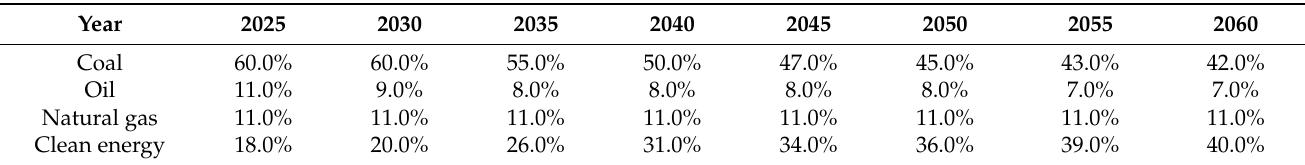
Table 7. The prediction of energy structure in